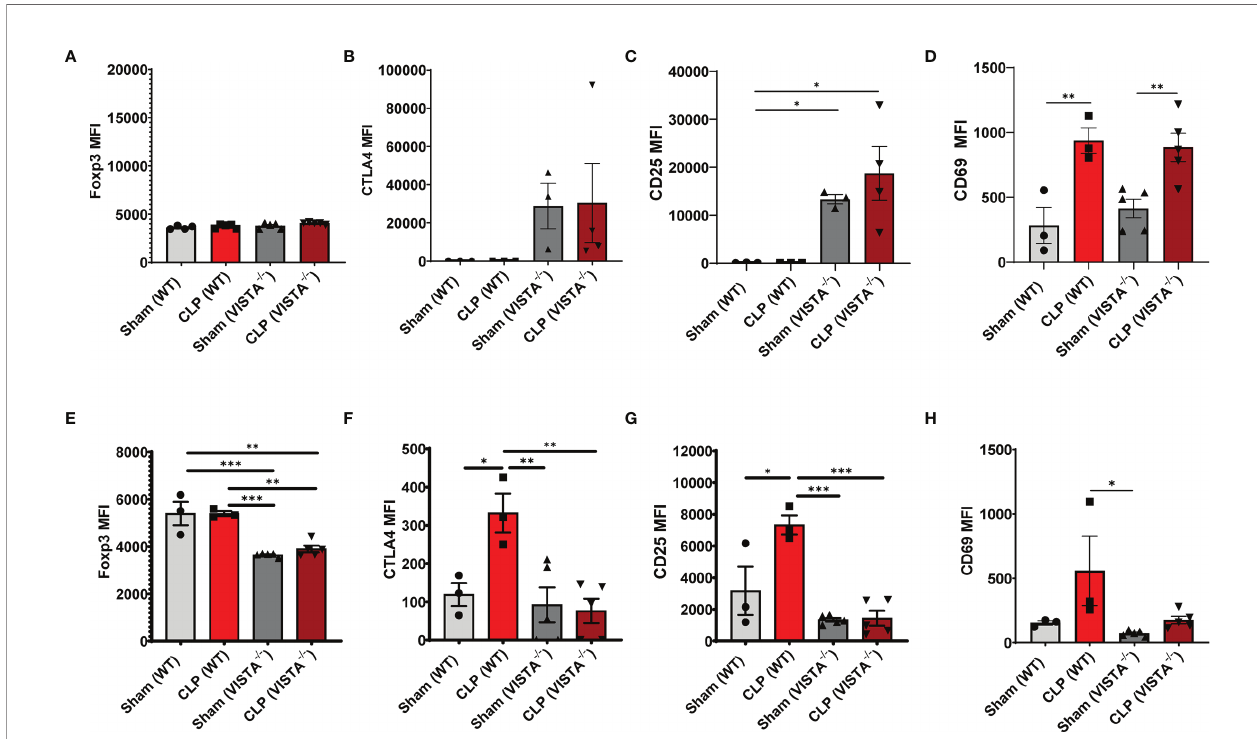
FIGURE 6 | Expression of suppressive markers is upregulated on CD4 + T regs and is downregulated on CD4 + CD8 + T regs in the thymus of VISTA -/- mice. Median fl uorescence intensity (MFI) of (E) Foxp3, fl uorescence intensity (MFI) of (A) Foxp3, (B) CTLA4, (C) CD25, and (D) CD69 on CD4 + T regs in the thymus. Median (F) CTLA4, (G) CD25, and (H) CD69 on CD4 + CD8 + T regs in the thymus. Summary graphs show mean ± SEM [WT-sham: n = 3 , WT-CLP: n = 3 , VISTA -/- sham: n = 4 , VISTA -/- -CLP: n = 4 ]; signi fi cance *p < 0.05; **p < 0.01; ***p <